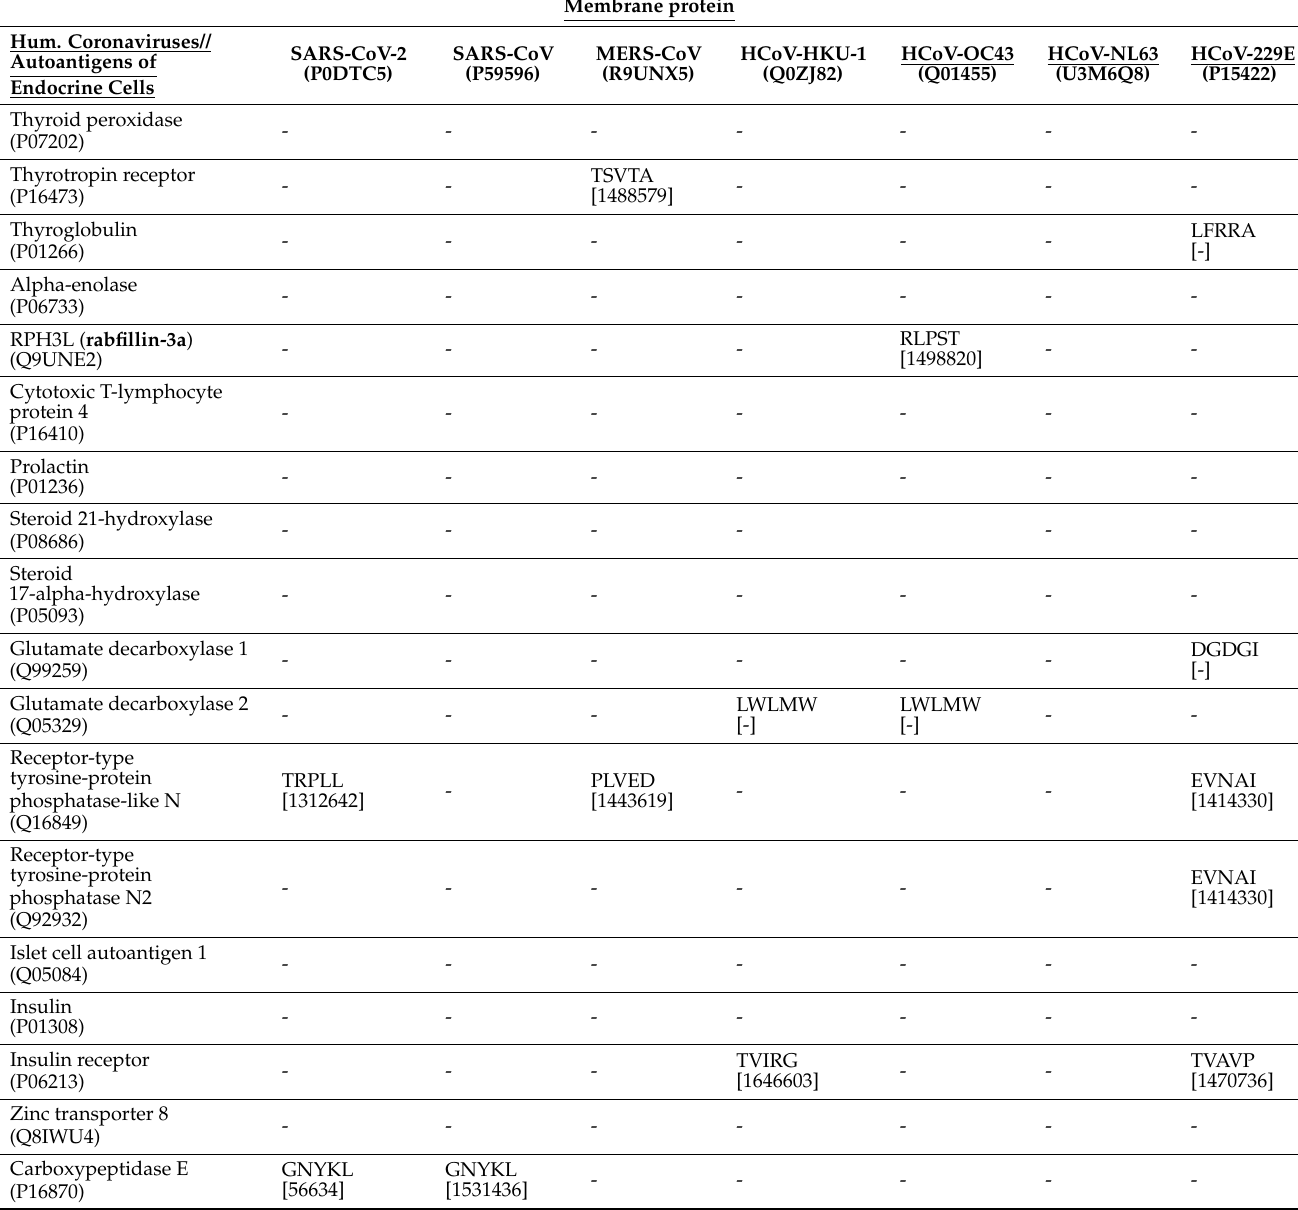
Table 2. Membrane proteins of human coronaviruses and autoantigens common for autoimmune Epitope Data Base for Human Coronaviruses membrane proteins are shown in the square brackets for each